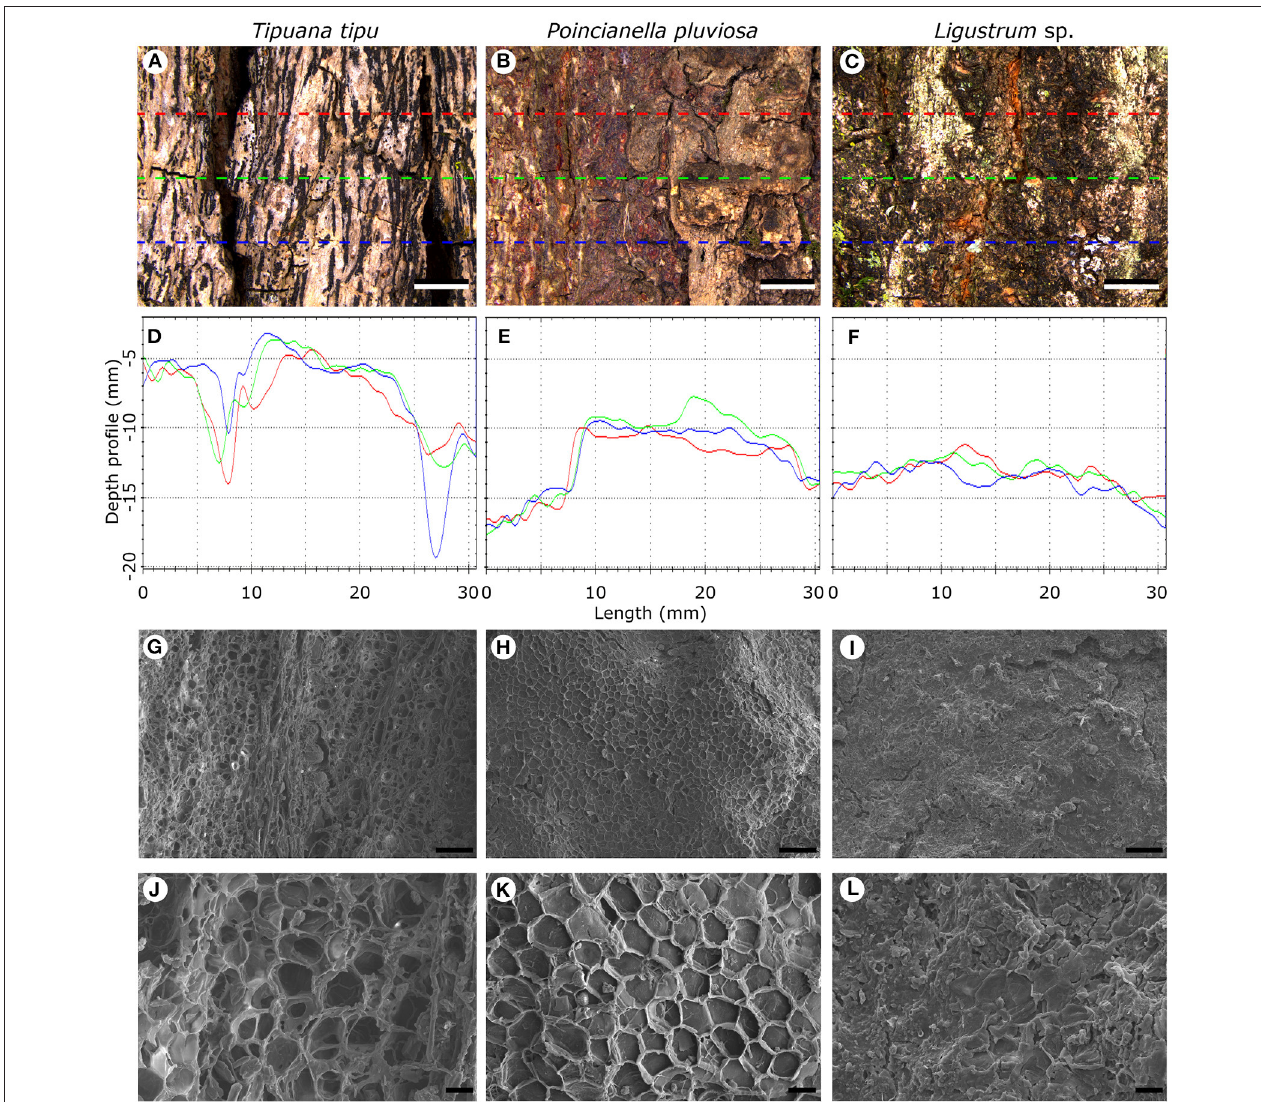
FIGURE 3 | External bark morphology of Tipuana tipu , Poincianella pluviosa and Ligustrum sp. including a macroscopic view of the bark surface ( A–C , 5mm) and the respective depth profiles of surface height variability ( D–F ; line colors represent the transects highlighted as dashed lines in the macroscopic images); a microscopic view of the surface porosity in lower ( G–I , 100 µ m) and higher magnification ( J–L , 20 µ m).